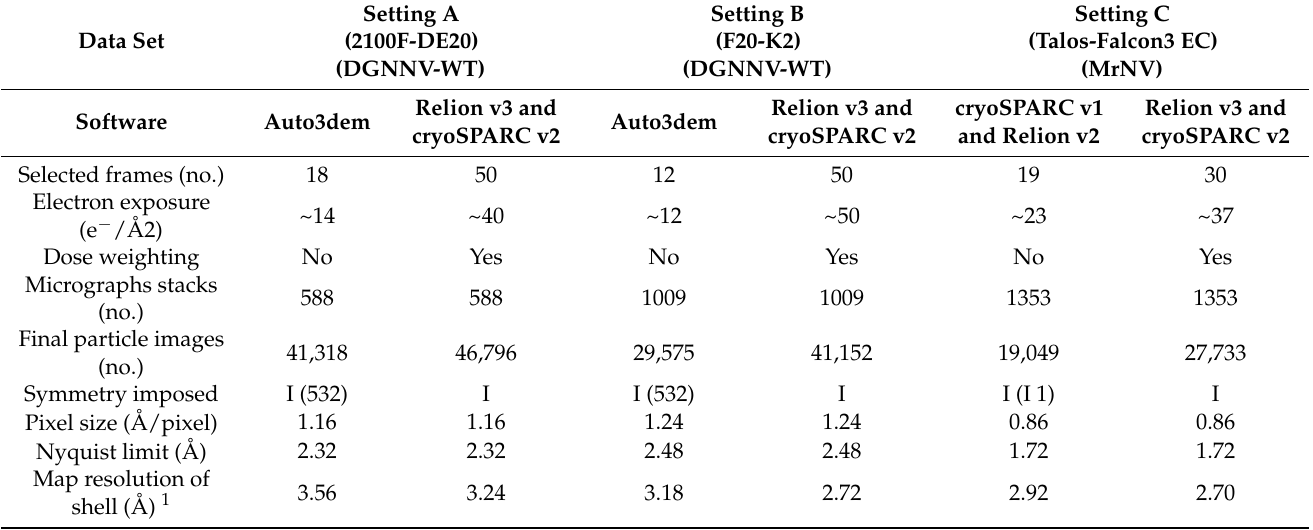
Table 1. Cryo-EM 3D refinement and